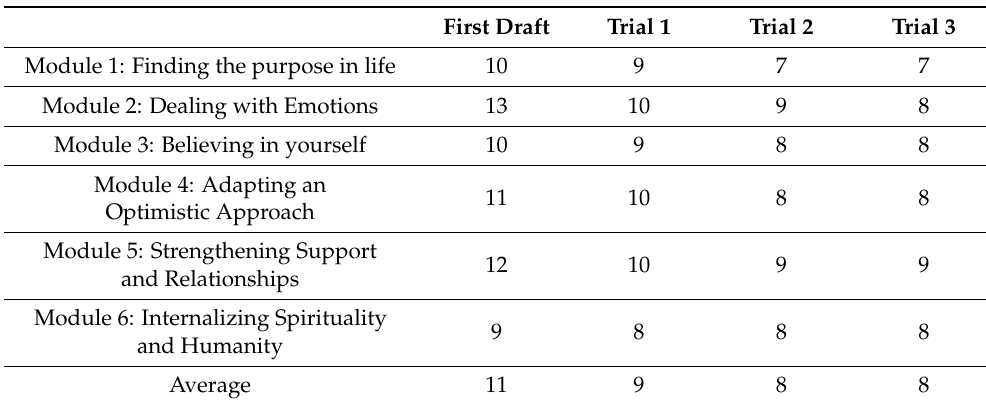
Table 3. Gunning Fox Index Calculation.